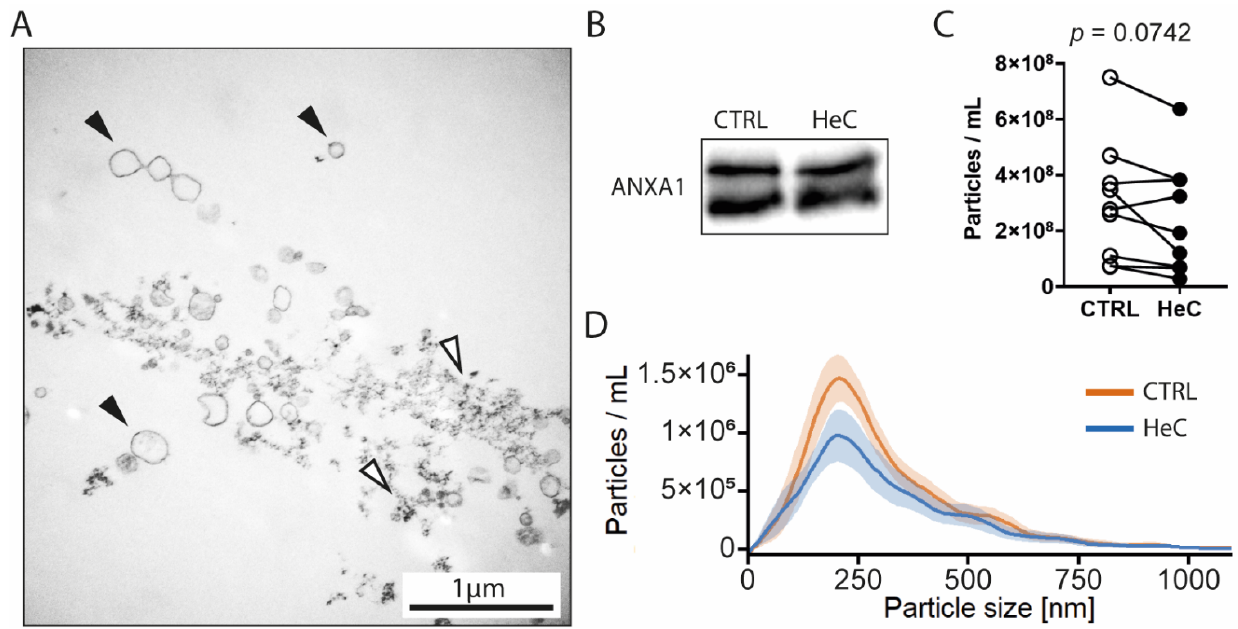
Figure 2. HeC tends to decrease NRCF mEV secretion: ( A ) EM image of mEV isolate, black arrow: membrane vesicles; white arrow: protein aggregates; ( B ) Qualitative analysis of Annexin A1 expression of mEVs with WB; ( C ) NTA concentration analysis of mEV isolates; ( D ) NTA size distribution analysis of mEV isolates. Results are represented as mean ± SEM.